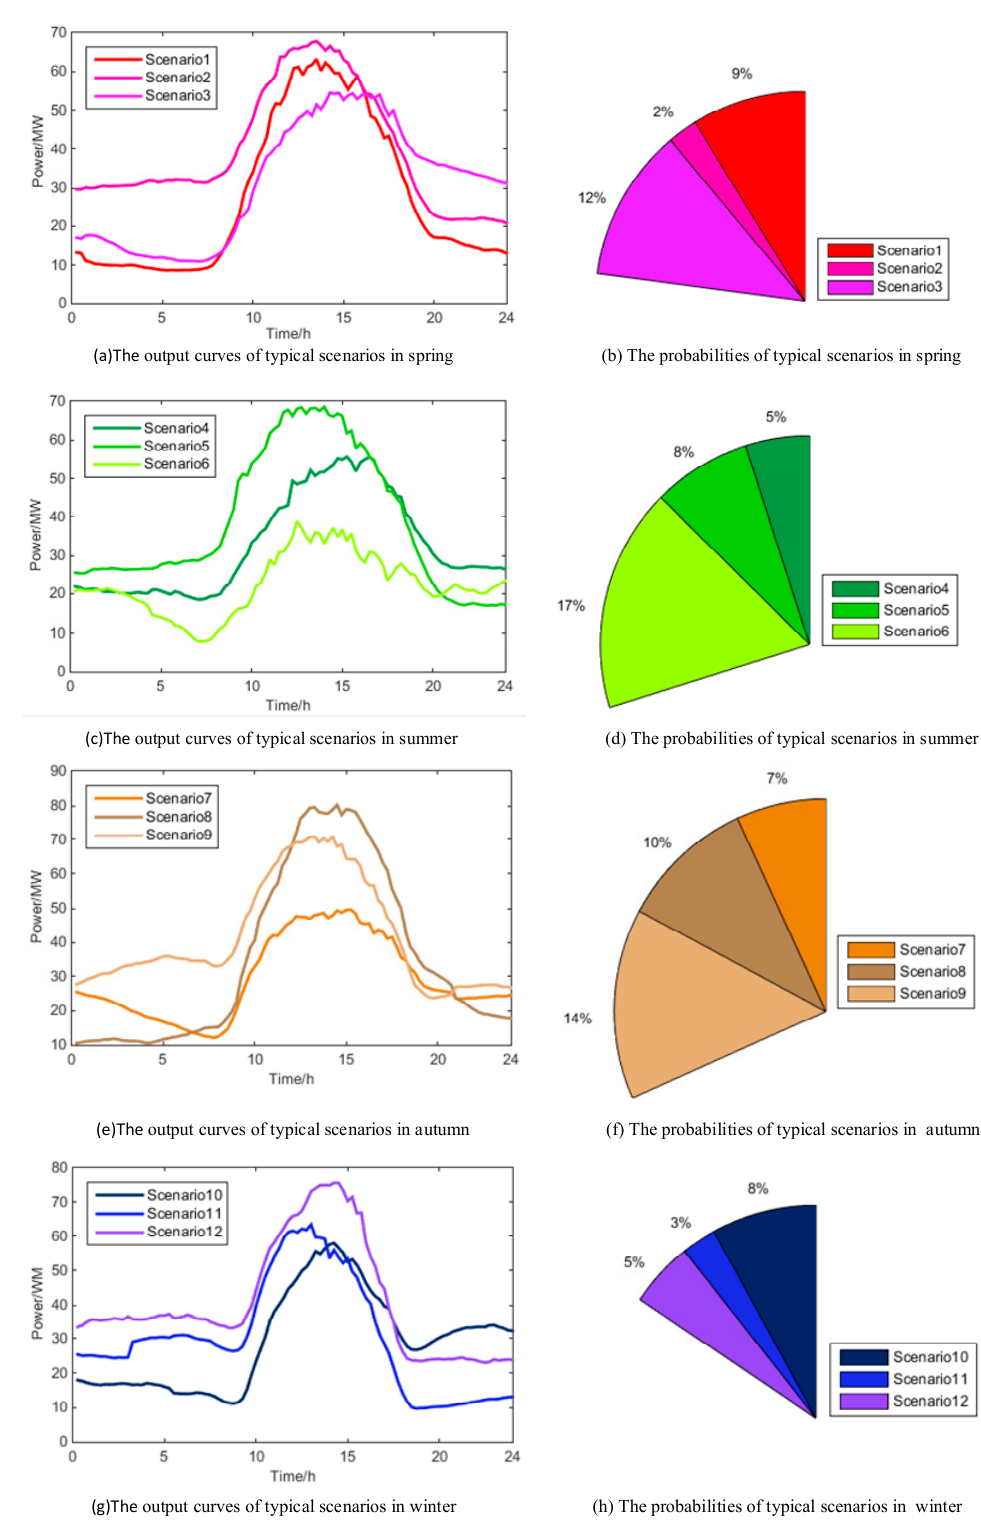
Figure 5. The output curves and probabilities of typical scenarios of all seasons. ( a ) The output of typical scenarios in spring; ( b ) The probabilities of typical scenarios in spring; ( c ) The output of typical scenarios in summer; ( d ) The output of typical scenarios in autumn; ( e ) The output of typical scenarios in autumn; ( f ) The probabilities of typical scenarios in autumn; ( g ) The output of typical scenarios in winter; ( h ) The output of typical scenarios in winter.